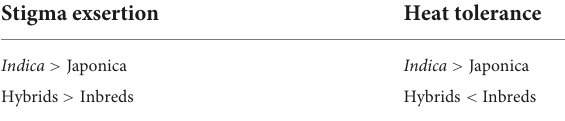
TABLE 1 The stigma exsertion and heat tolerance of rice